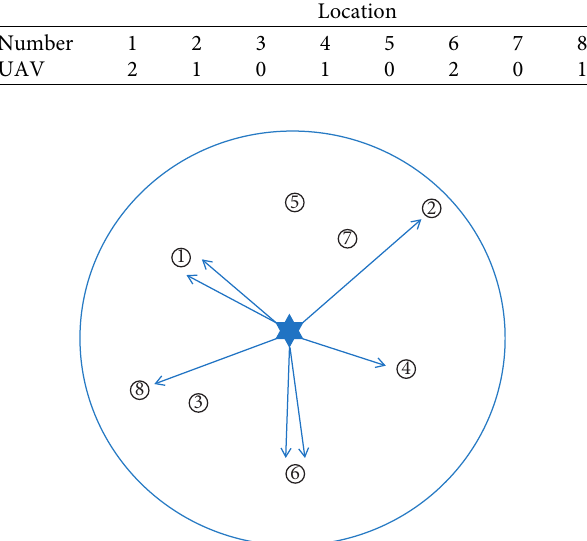
Figure 5: The effect of the first task